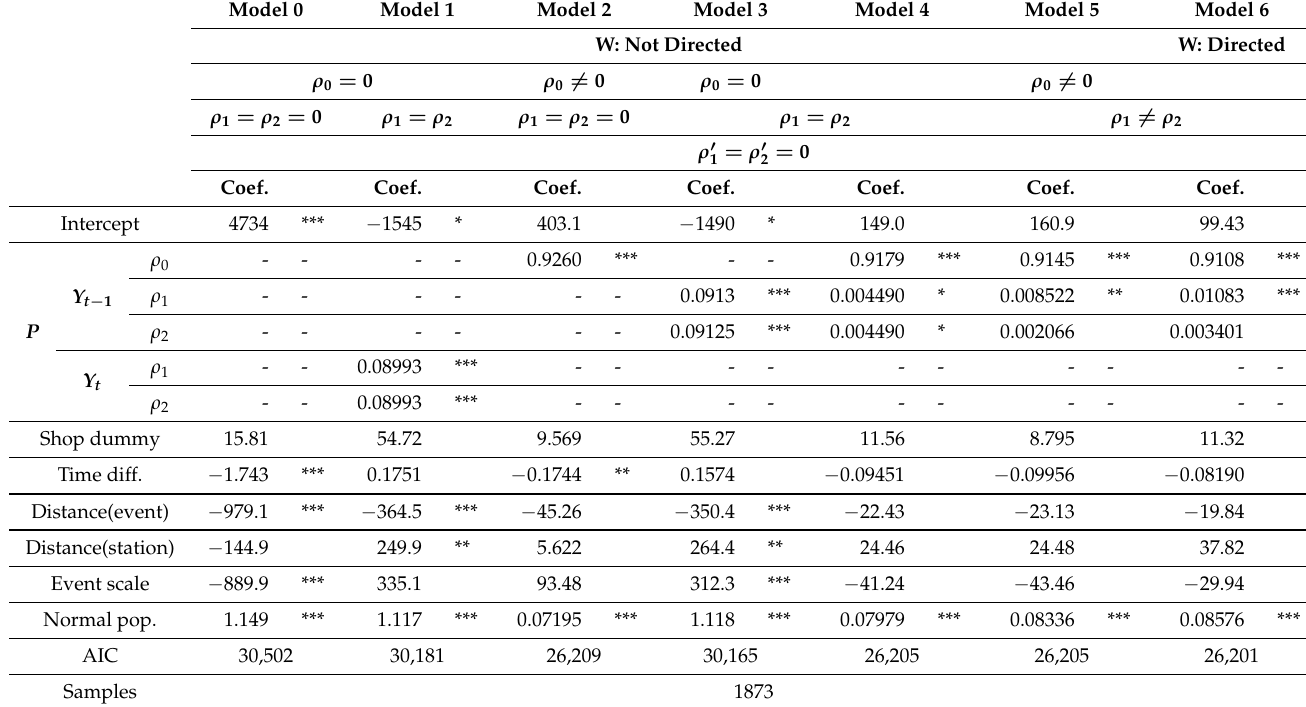
Table 5. Results of models (using data after event closing).